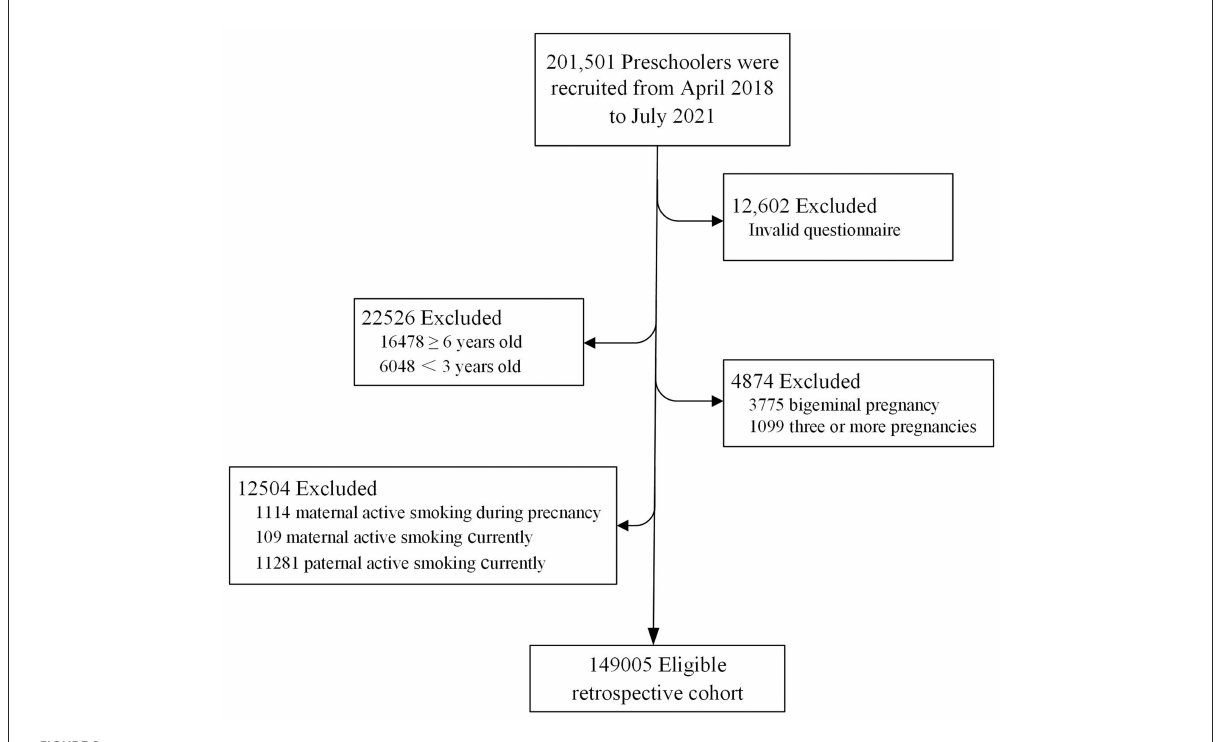
FIGURE2 Flowchart of the study